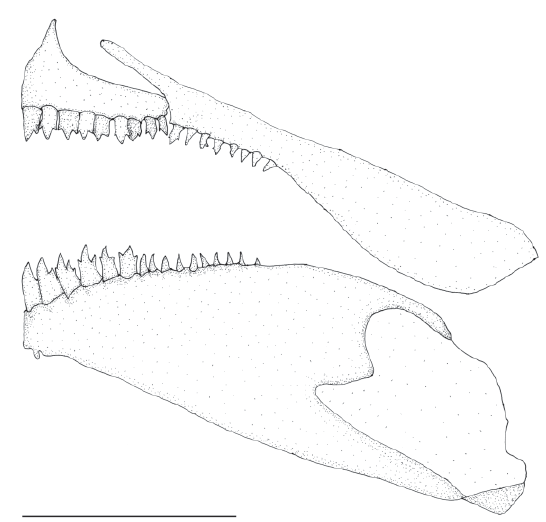
Fig. 7. Hyphessobrycon eilyos , paratype, MZUSP 41406. Upper and lower jaws, lateral view, left side. Scale bar 1mm.